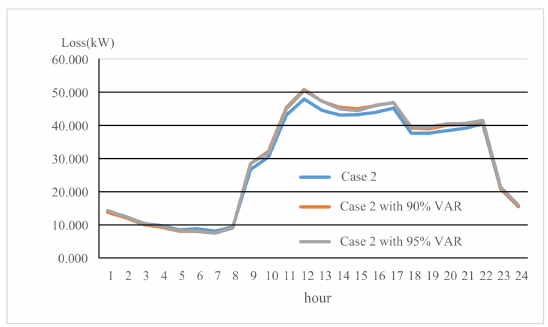
Figure 13. The VAR of daily system loss at the various confidence levels.